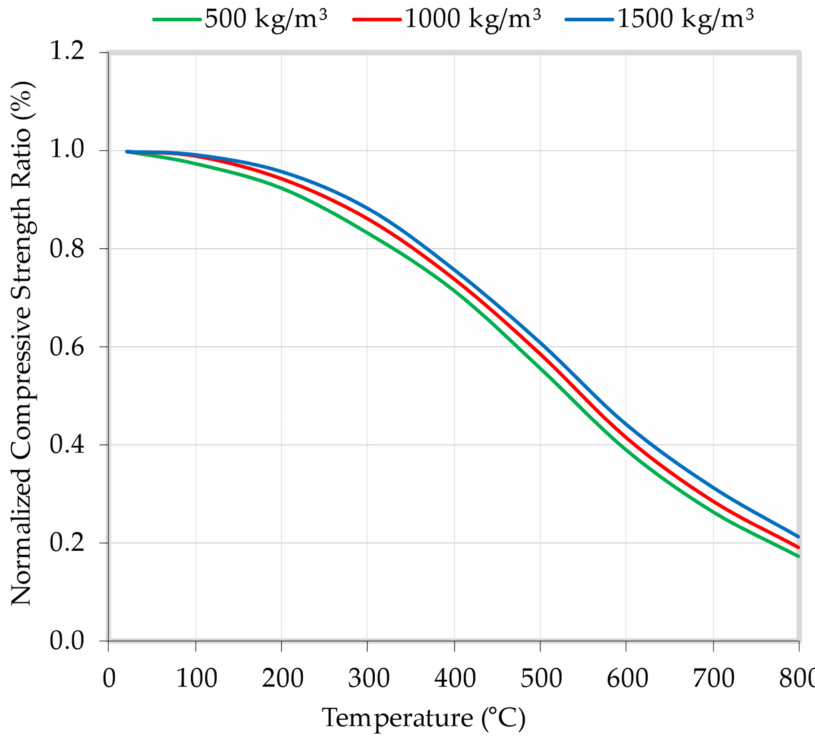
Figure 9. Influence of varying temperatures on the normalized LFC compressive